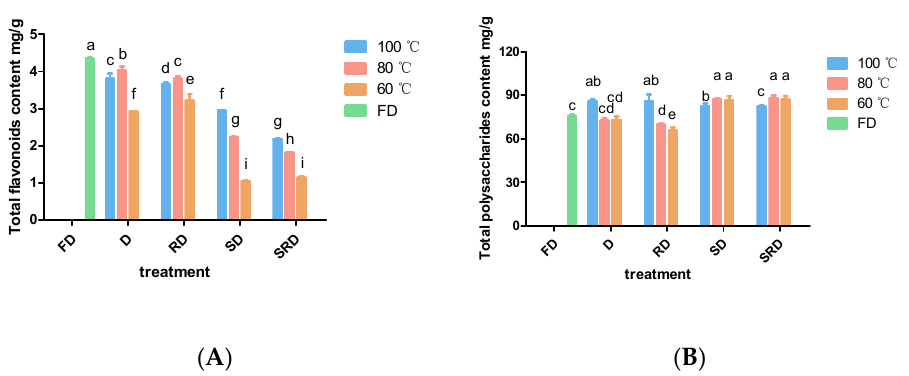
Figure 3. Total flavonoid and polysaccharide contents of Dendrobium catenatum leaves are shown after exposure to various processing methods: ( A ) total flavonoid content and ( B ) total polysaccharide content. Columns represent the mean ( n = 3) ± standard deviation. Columns of the same shape with different letters indicate significant differences ( p < 0.05).